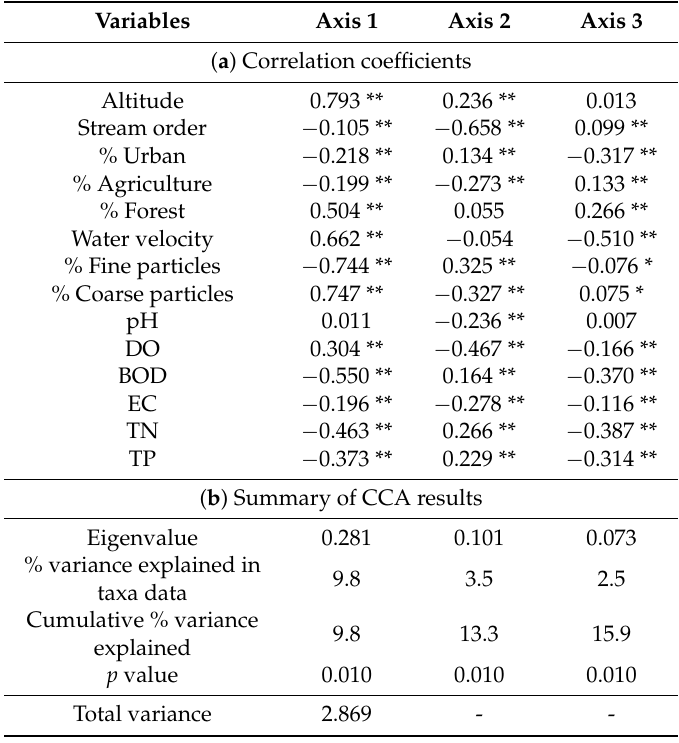
Table 4. Spearman’s rank correlation coefficients and probabilities of environmental variables and the CCA axes (** p < 0.01, * p < 0.05) ( a ), and summary of CCA results ( n = 720) ( b ). All axes were significant based on Monte Carlo permutation